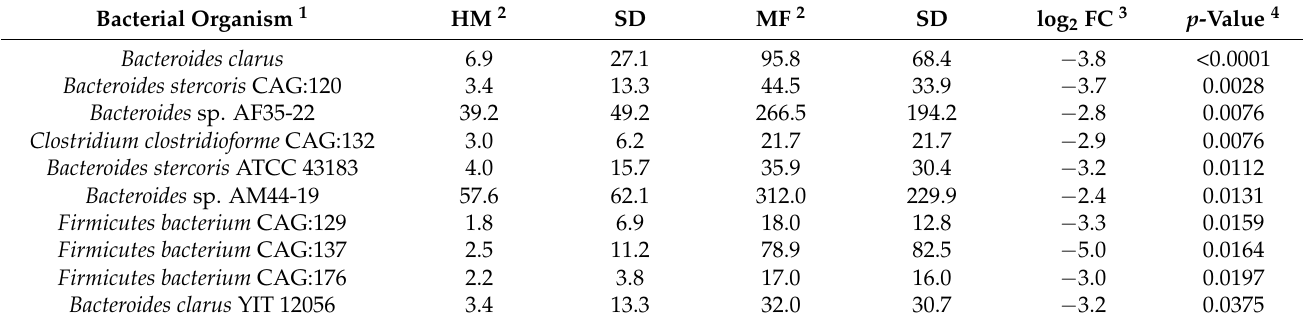
Figure 2. Metaproteomics-derived protein profiles uniquely defined in HM and MF-fed neonatal piglets. Heatmap constructed from differentially abundant proteins is shown. The two dietary groups are indicated by the bottom labels: HM and MF ( n = 11/group). Unsupervised clustering of bacterial and host protein resulted in HM and MF piglets being grouped together. Host and human proteins are identified with *, red—human, blue—pig. Table 1. Cecal bacterial profile of piglets ( n = 11/group) fed either with human milk (HM) or milk formula (MF) at PND 21. Bacterial Organism